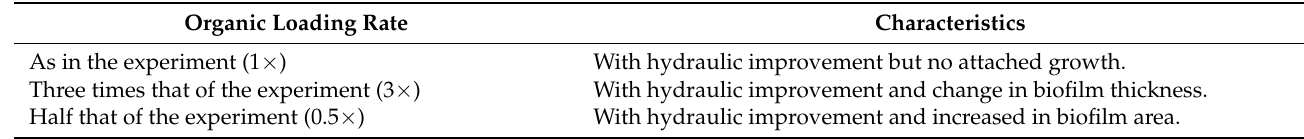
Table 2. Scenarios for generalising the kinetic model in BOD removal efficiency prediction. There are three organic loading rates and each were tested with three distinct sets of characteristics, making nine scenarios. Organic Loading Rate Characteristics As in the experiment (1 × ) With hydraulic improvement but no attached growth. Three times that of the experiment (3 × ) With hydraulic improvement and change in biofilm thickness. Half that of the experiment (0.5 × ) With hydraulic improvement and increased in biofilm